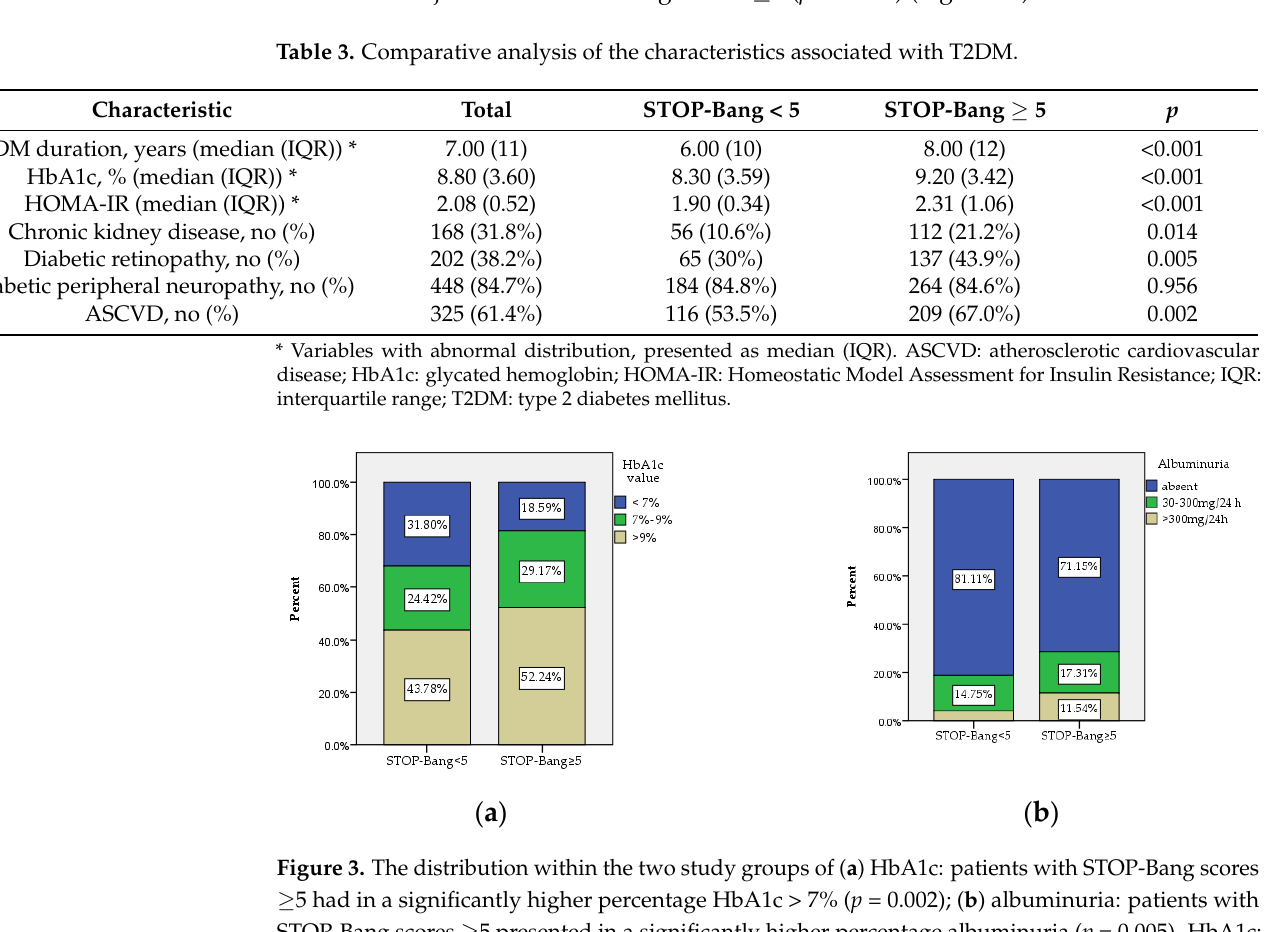
Table 3. Comparative analysis of the characteristics associated with T2DM.